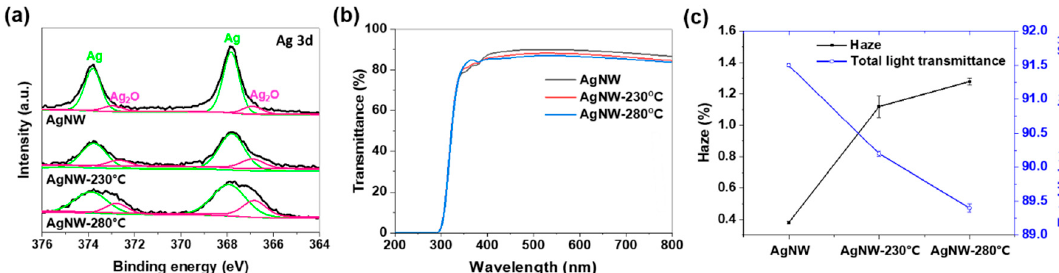
Figure 2. ( a ) Ag 3d core-level XPS high-resolution spectra, ( b ) transmittance and photo, and ( c ) haze and total light transmittance of AgNW, AgNW-230 °C, and AgNW-280 °C.